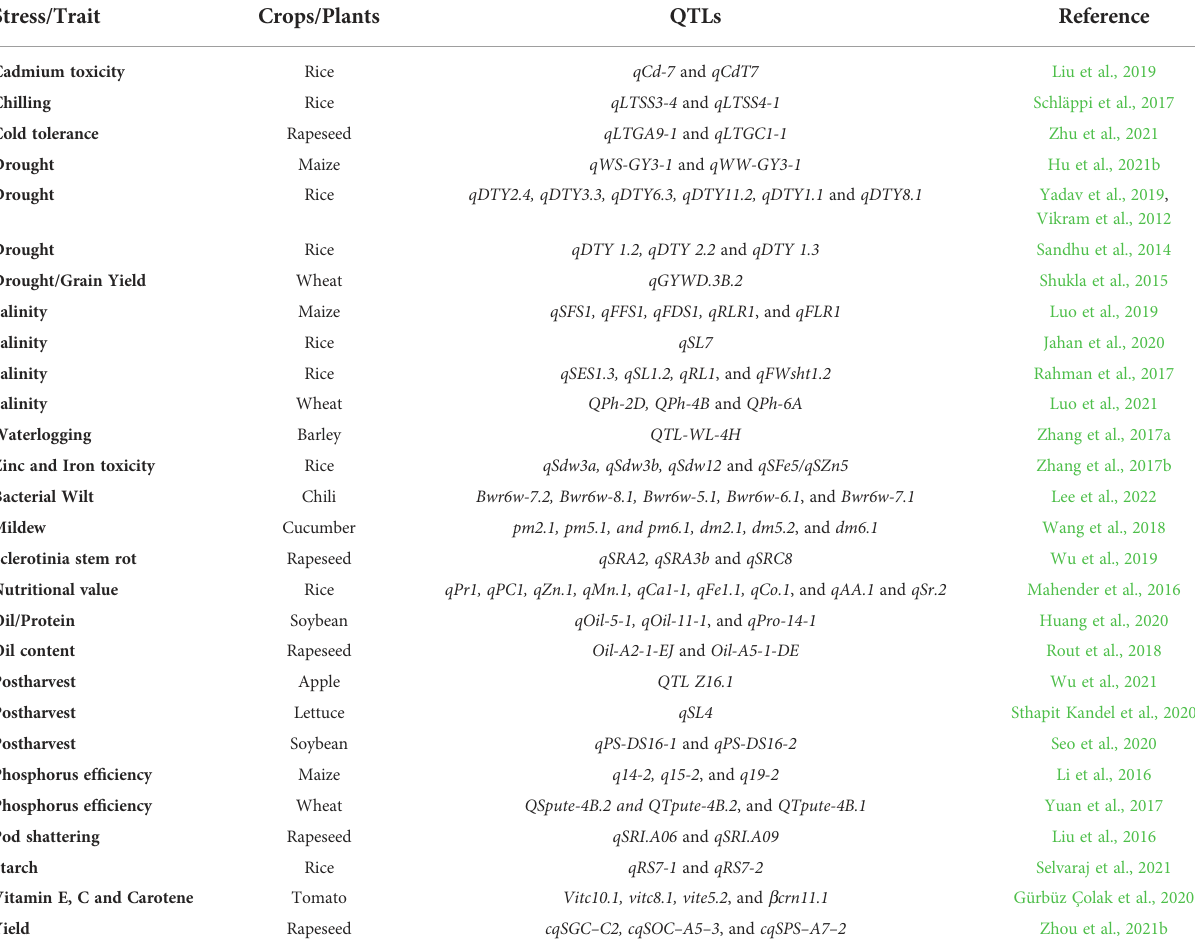
TABLE 3 List of stress (abiotic and biotic), nutrition, quality, and post-harvest related QTLs for future crop improvements.